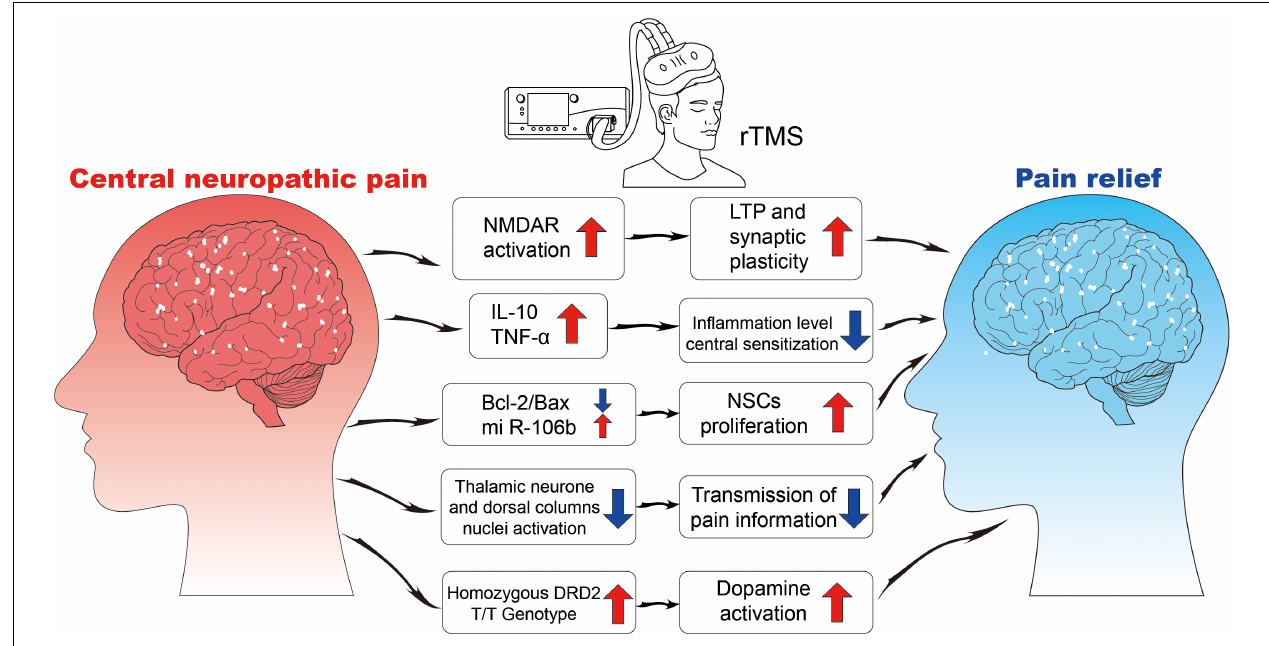
FIGURE 2 | The neurophysiological mechanisms of rTMS. NMDA, N-methyl-D-aspartate receptor; LTP, long-term potentiation; IL, interleukin; TNF, tumor necrosis factor; Bcl, B-cell lymphoma; Bax, Bcl2-associated X; NSCs, neural stem cells; DRD2, dopamine receptor